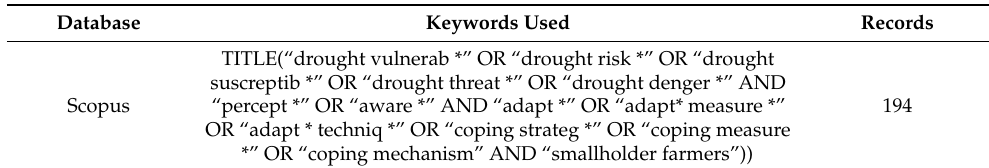
Table 2. The used systematic review search string.